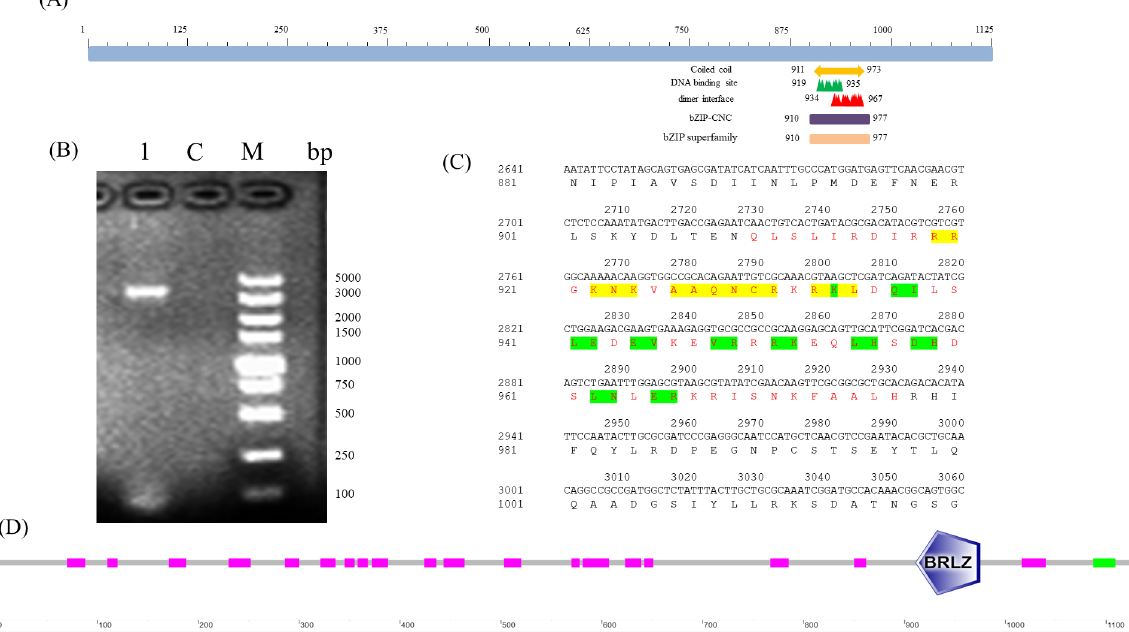
Figure 1. Functional domain prediction based on the BdCncC amino acid sequence. ( A , D ) Schematic illustration of BdCncC ; ( B ) electrophoresis of BdCncC PCR products; M: DNA Marker DL5000; C: control group; 1: PCR product; ( C ) amino acid sequence structure of BdCncC , where red letters represent the conserved regions of the BdCncC protein, including the basic region domain and leucine zipper—yellow highlighting indicates the DNA-binding site, and green highlighting indicates the dimer interface site.